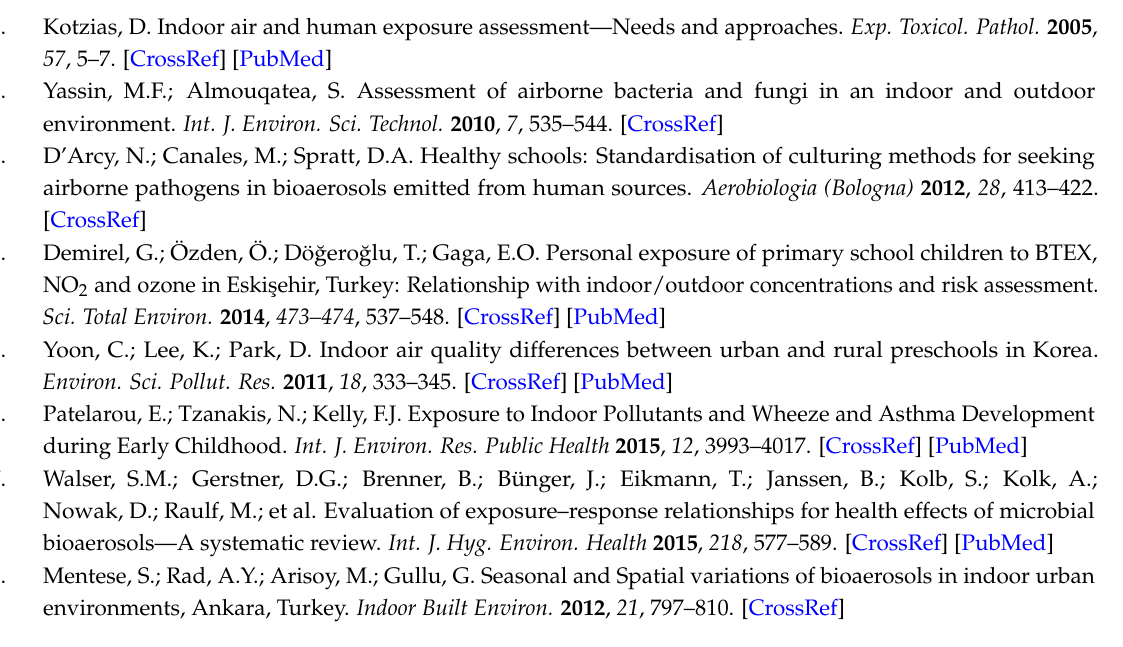
Figure S1: Comparison of size distribution of bacterial aerosols in classrooms of younger and older children during winter and spring seasons in nursery school (S). ( a ) Classroom of younger children-spring, ( b ) Classroom of younger children-winter, ( c ) Classroom of older children-spring, ( d ) Classroom of older children-winter, Figure S2: Comparison of size distribution of fungal aerosols in classrooms of younger and older children during winter and spring seasons in nursery school (S). ( a ) Classroom of younger children-spring, ( b ) Classroom of younger children-winter, ( c ) Classroom of older children-spring, ( d ) Classroom of older children-winter, Figure S3: Comparison of size distribution of bacterial aerosols in classrooms of younger and older children during winter and spring seasons in nursery school (P). ( a ) Classroom of younger children-spring, ( b ) Classroom of younger children-winter, ( c ) Classroom of older children-spring, ( d ) Classroom of older children-winter, Figure S4: Comparison of size distribution of fungal aerosols in classrooms of younger and older children during winter and spring seasons in nursery school (P). ( a ) Classroom of younger children-spring, ( b ) Classroom of younger children-winter, ( c ) Classroom of older children-spring, ( d ) Classroom of older children-winter, Table S1: Viable bacterial genera identified outdoors and indoors nursery school (S) during winter and spring seasons, Table S2: Viable bacterial genera identified outdoors and indoors nursery school (P) during winter and spring